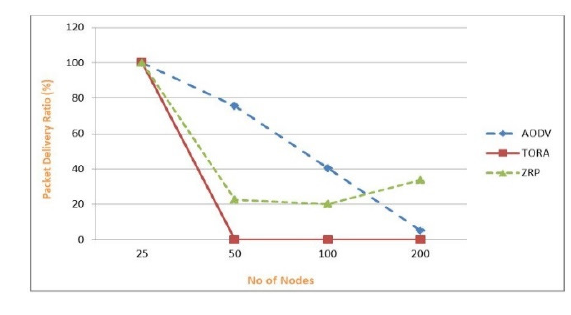
little when the number of node moves from 50 to 100 hosts.